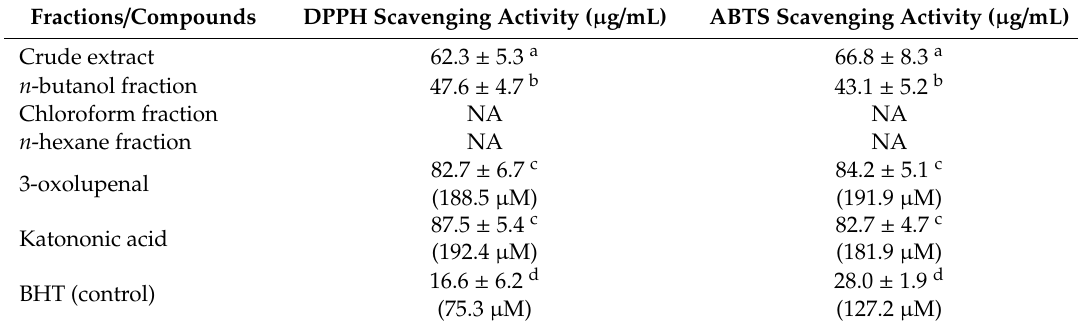
NA: No activity was observed; BHT: Butylated